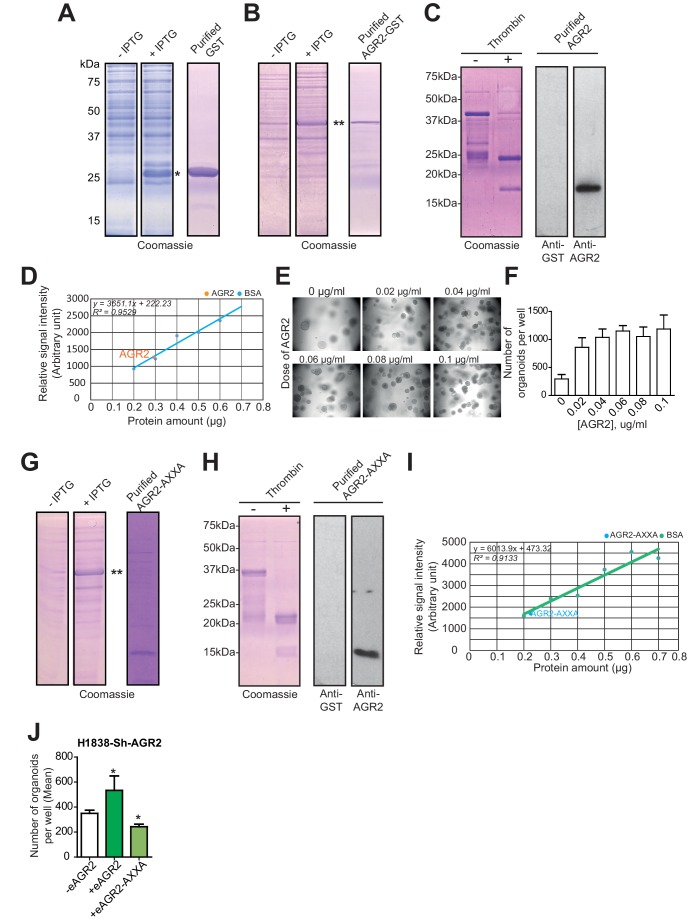
AGR2 and AGR2 thioredoxin mutant (AGR2-AXXA) purification and activity on organoids formation.(A) Coomassie stained SDS-PAGE gel showing GST induction with IPTG (left panels) and purified GST control proteins (right panel). Asterisk (*) indicate GST product. (B) Coomassie stained SDS-PAGE gel showing GST-AGR2 induction with IPTG (left panels) and purified AGR2-GST proteins (right panel). Asterisk (**) indicate AGR2 fused to GST product. (C) Coomassie stained SDS-PAGE gel showing GST-AGR2 cleaved with thrombin (left panels) and purified AGR2 was confirmed using an anti-AGR2 or anti-GST antibody. (D) The concentration of the purified AGR2 was obtained from a Bovine serum albumin (BSA) standard curve. (E) Representative images of the organoids formed following different dose of AGR2 (+) as compared to untreated cells (-). (F) The bar graph shows the mean of organoids per well (mean ± SEM) after 10 days of culture from three independent experiments. (G) Coomassie stained SDS-PAGE gel showing AGR2-AXXA-GST induction with IPTG (left panels) and AGR2-AXXA-GST cleaved with thrombin (right panel). Asterisks (**) indicate AGR2-AXXA-GST product. (H) Coomassie stained SDS-PAGE gel showing AGR2-AXXA-GST cleaved with thrombin (left panels) and purified AGR2-AXXA was confirmed using an anti-AGR2 or anti-GST antibody. (I) The concentration of the purified AGR2-AXXA was obtained using a Bovine serum albumin (BSA) standard curve. (J) The bar graphs show the number of organoids per well in absence (-eAGR2) of eAGR2 as compared to organoids in presence either of AGR2-AXXA mutant (+eAGR2-AXXA) or AGR2 wt (+eAGR2) in H1838 Sh-AGR2 depleted cells. Data are mean ± SEM. *p<0.05.